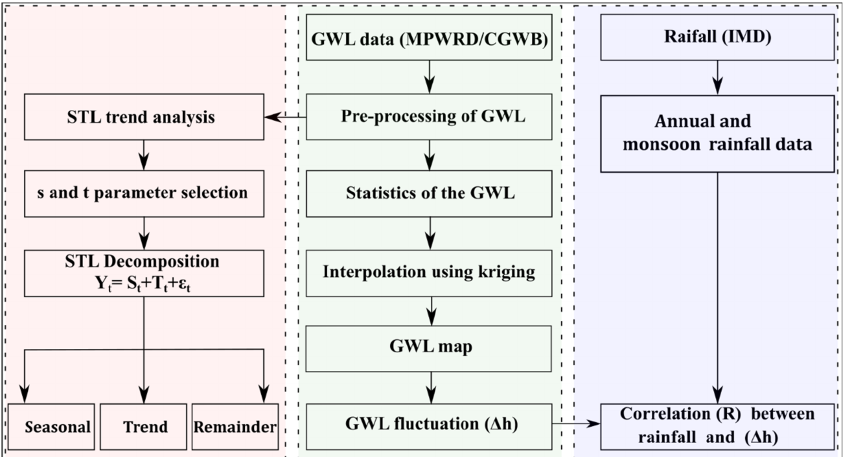
Figure 2. Flow chart illustrates the detailed methodology of this study. The pre-processing of GWL data and estimation of GWL fluctuation are shown in the center box. The STL decomposition of GWL data is shown on the left box. The correlation between monsoon rainfall and GWL fluctuation is shown in the right box.